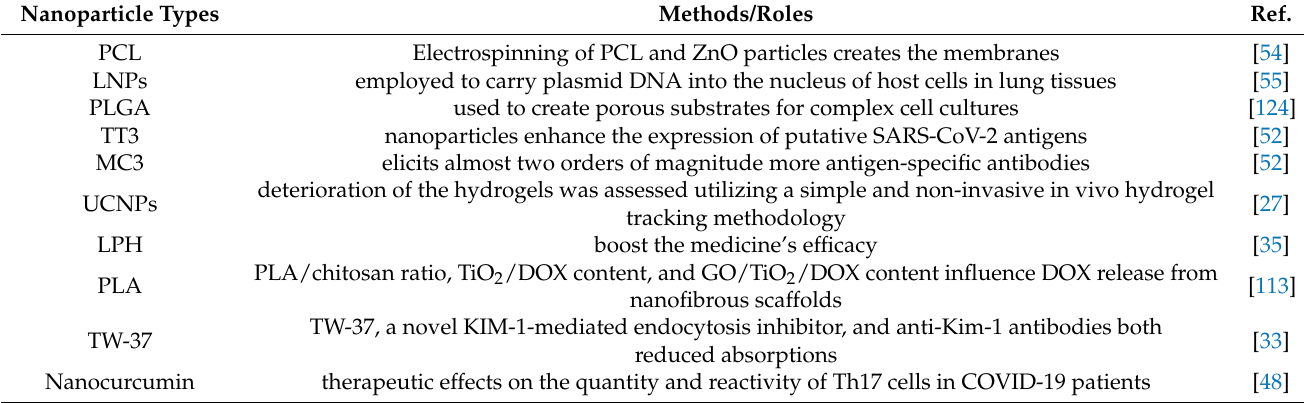
Table 1. Biopolymeric nanoparticle methods and roles in tissue regeneration. Nanoparticle Types Methods/Roles